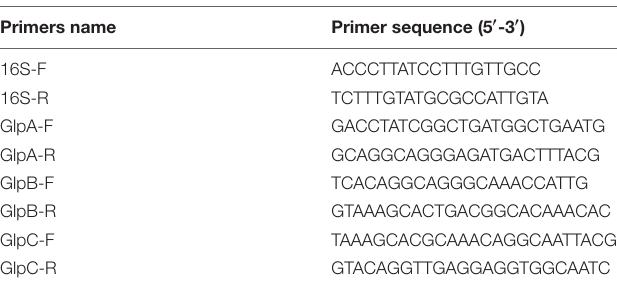
TABLE 2 | Primers for